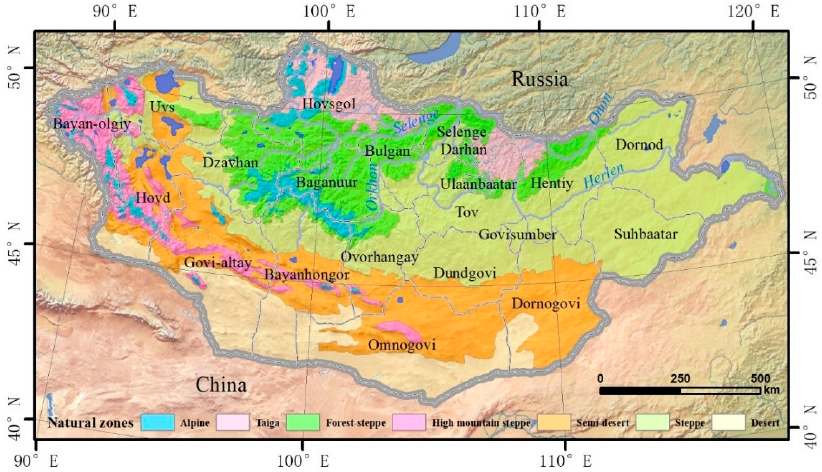
Figure 1. Location and natural features of Mongolia. The topographic base map was from [55].